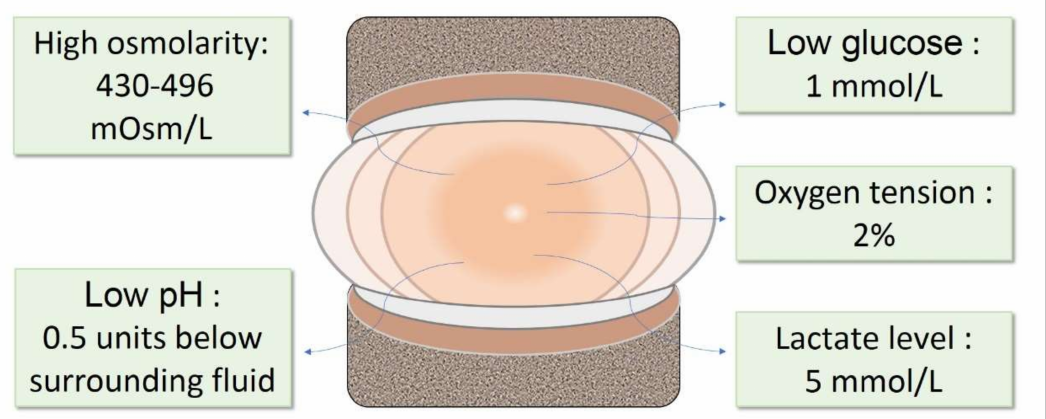
Figure 1. The physiochemical microenvironment in healthy NP. The NP in healthy IVDs is defined by low glucose, low pH, low oxygen tension, high lactate level, and high osmolarity. IVD: intervertebral disc; NP: nucleus